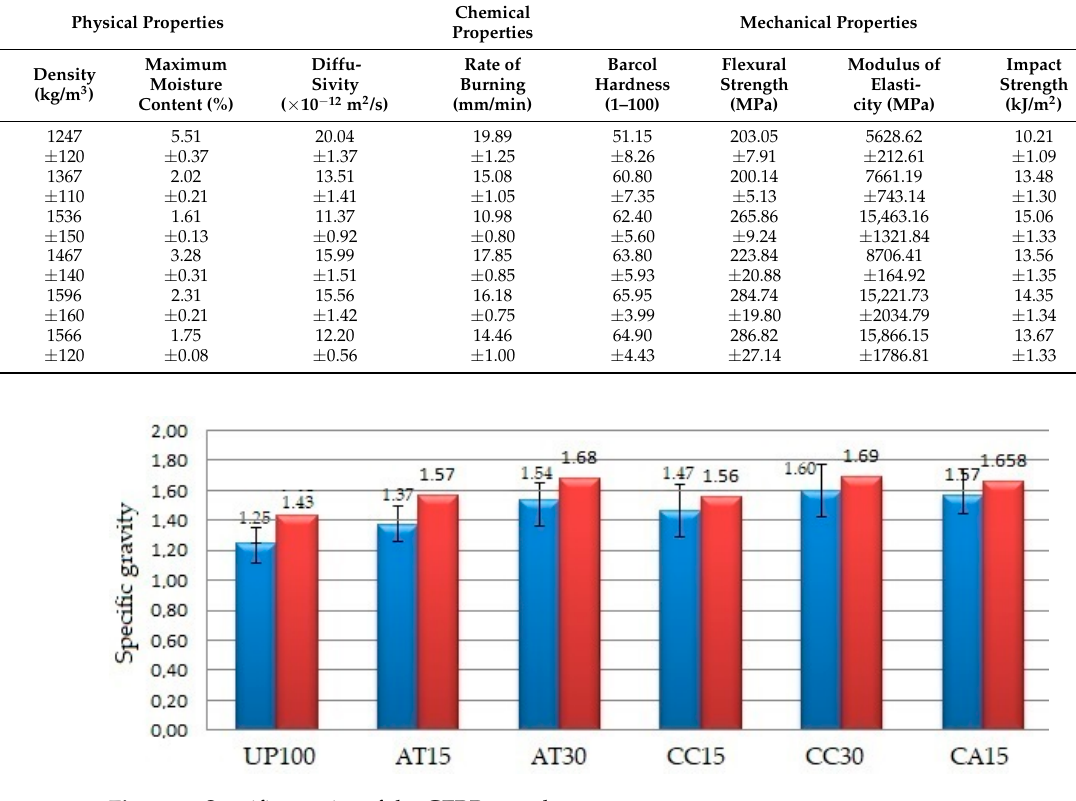
Table 2. Physical, chemical, and mechanical properties of the GFRP samples.